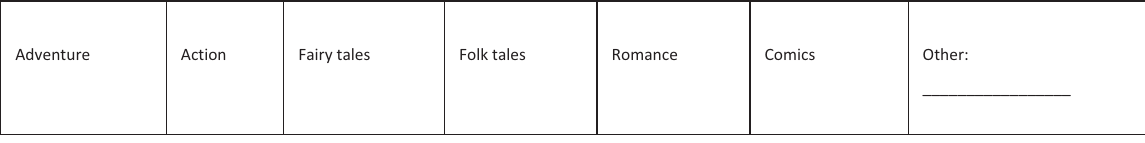
FIGURE 7: Question with types of stories.